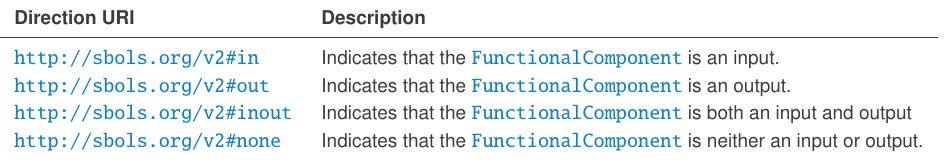
Table 10: REQUIRED URI s for the direction